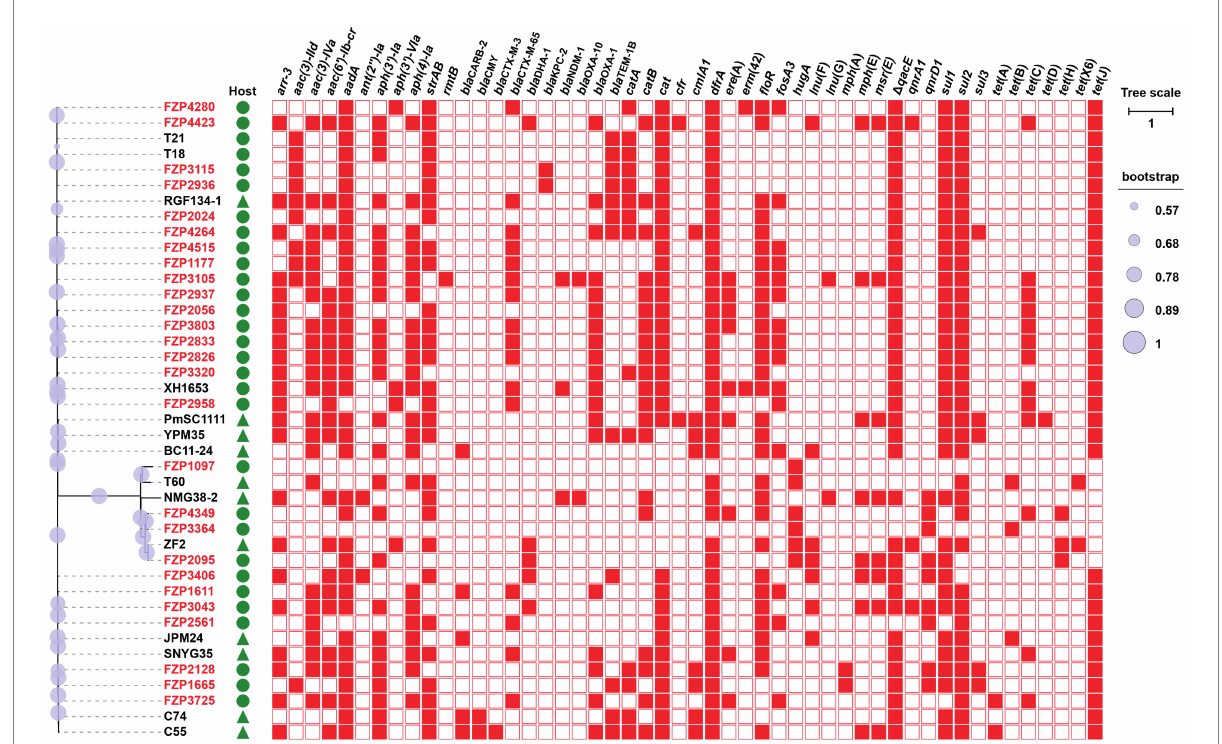
FIGURE 1 Phylogenetic analysis and antibiotic resistance gene (ARG) distribution of Proteus strains. Strains identified in this study are highlighted in red. The host of the isolate is indicated by triangles (animals) or circles (humans). The presence or absence of ARGs is indicated by filled or empty squares, respectively. The tree scale indicates substitutions per site. Detailed information of these strains is presented in Supplementary Table